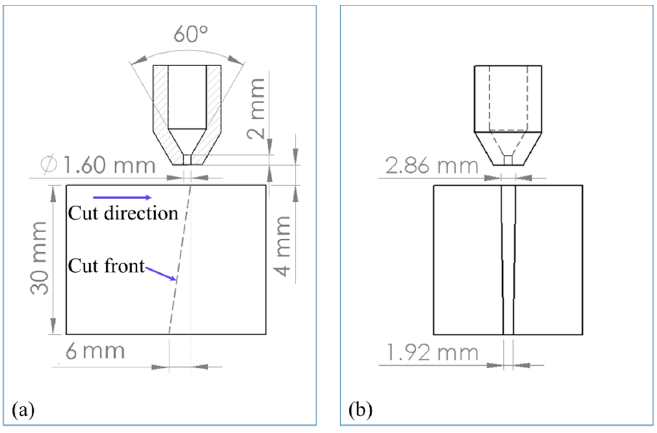
Figure 1. Nozzle and cut kerf geometry. ( a ) Front view. ( b ) Side view.